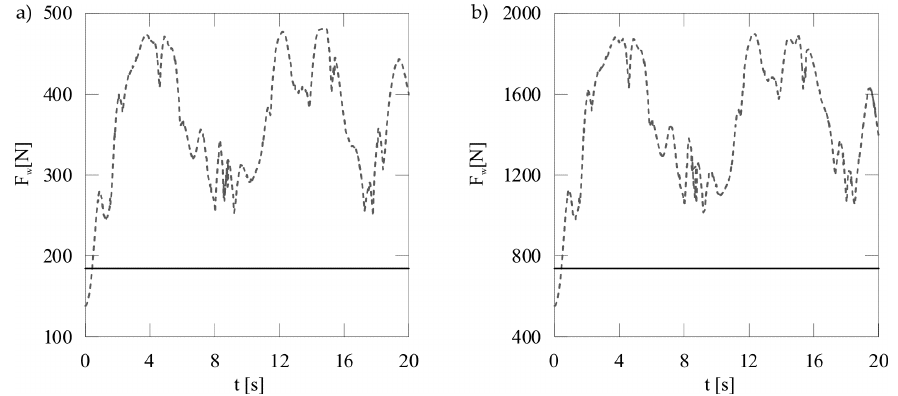
Figure 17. Value of the wind impact force with respect to wind velocity equal to ( a ) 10 m/s and ( b ) 20 m/s (continuous line—fixed area, dotted line—variable area).